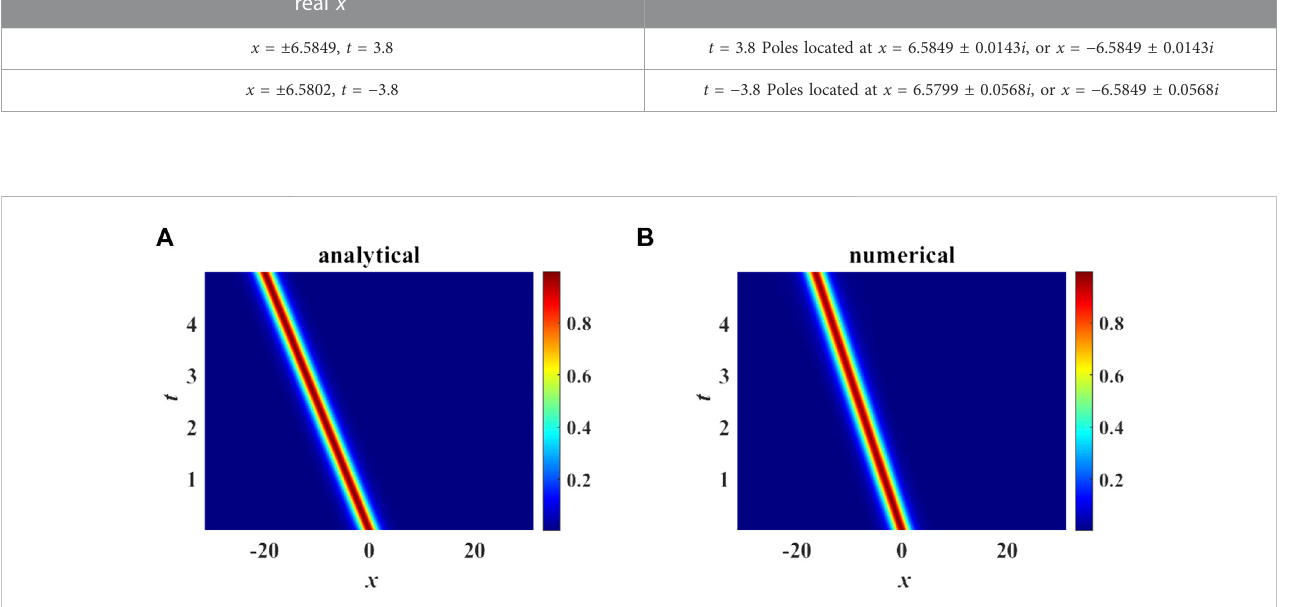
FIGURE 3 (A) Analytical and (B) Numerical soliton. Parameters chosen are κ = − 1, α = 1, β = 0.001, λ 1 = 1 − 0.5 i , λ 2 = 1 + 0.5 i